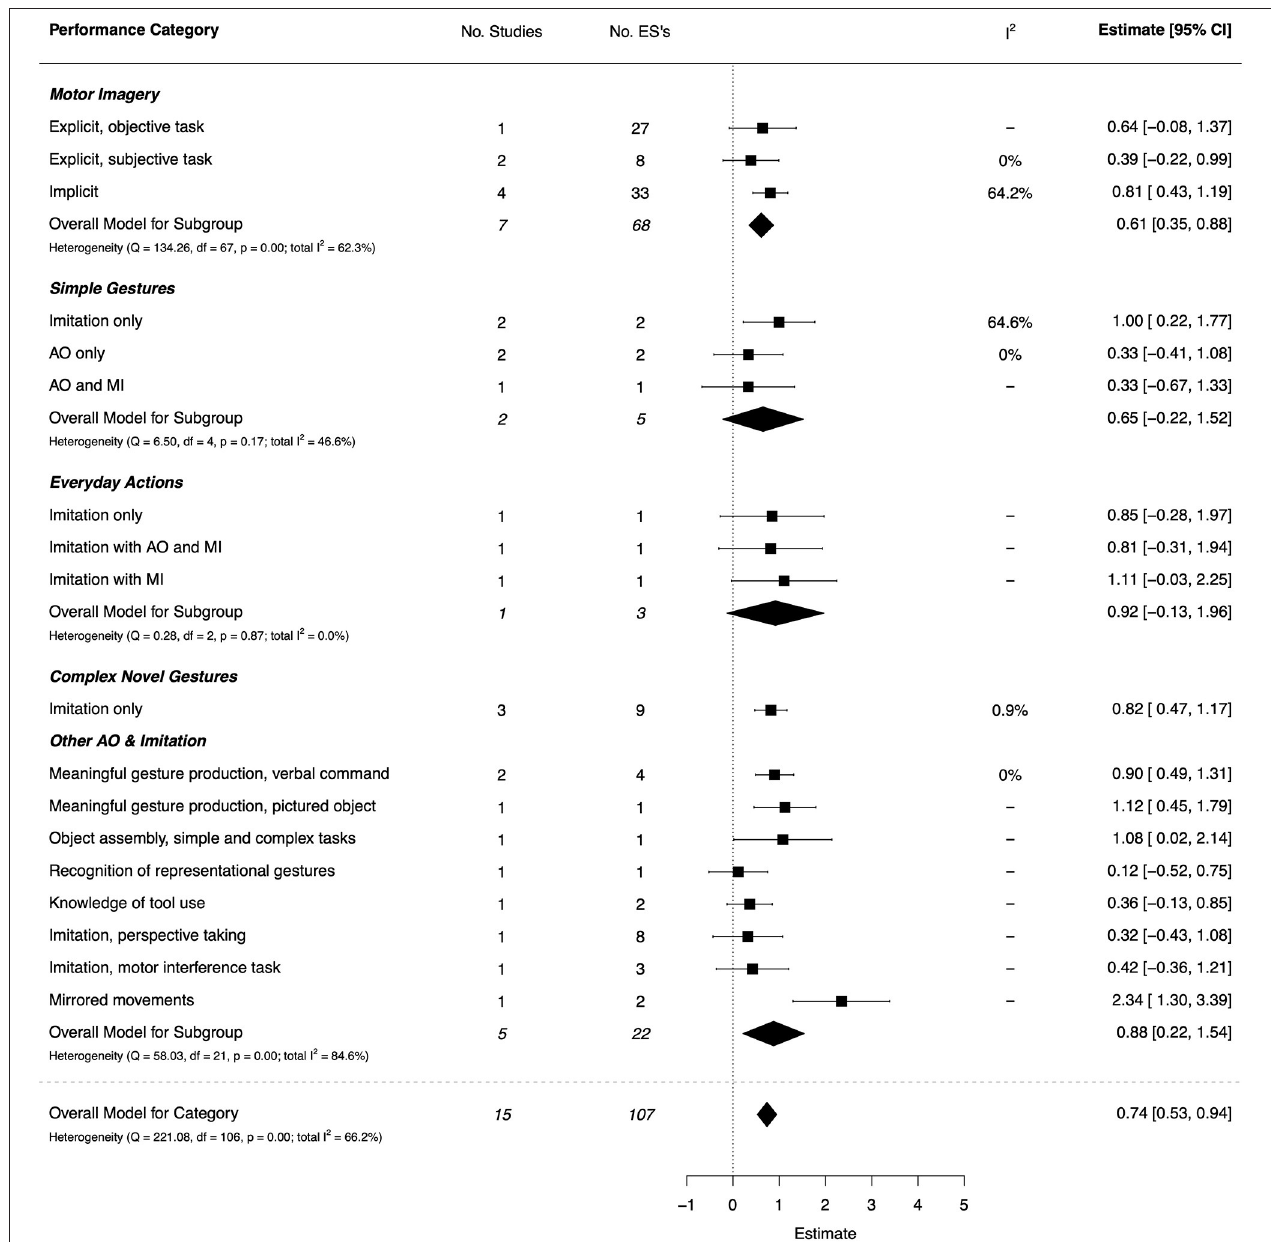
FIGURE 6 | Forest plot showing the meta-analysis results for the motor imagery, action observation, imitation, and gesture production performance category. AO, Action Observation; MI, Motor Imagery.